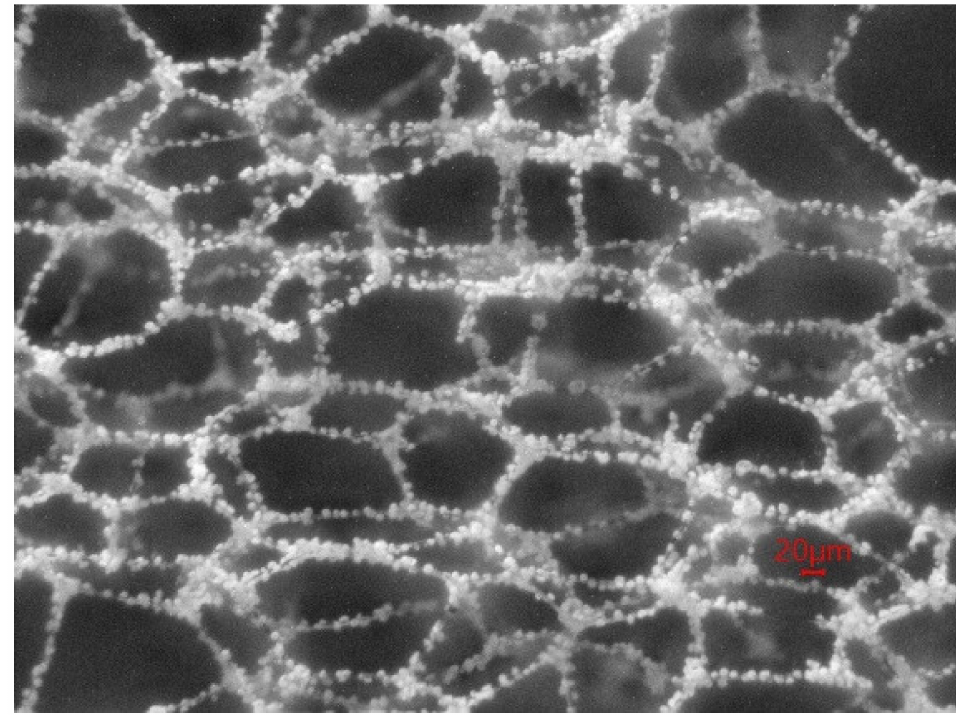
Figure 9. Microphoto of M1 material electrospun on foam